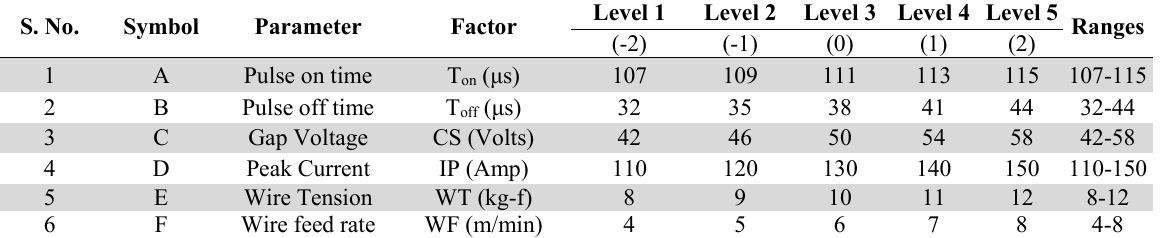
Experimental factors and their levels for wire electrical discharge machining process